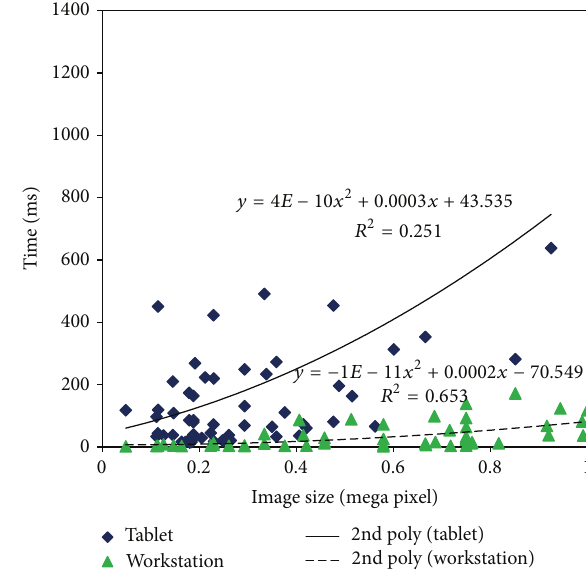
Figure 9: Computational time for image enhancement with differ- ent image size.